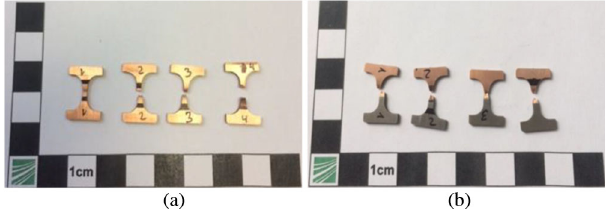
FIG. 13. Tensile samples containing (a) the CuCr1Zr-CuCr1Zr interface and (b) the CuCr1Zr-SS 316L interface.